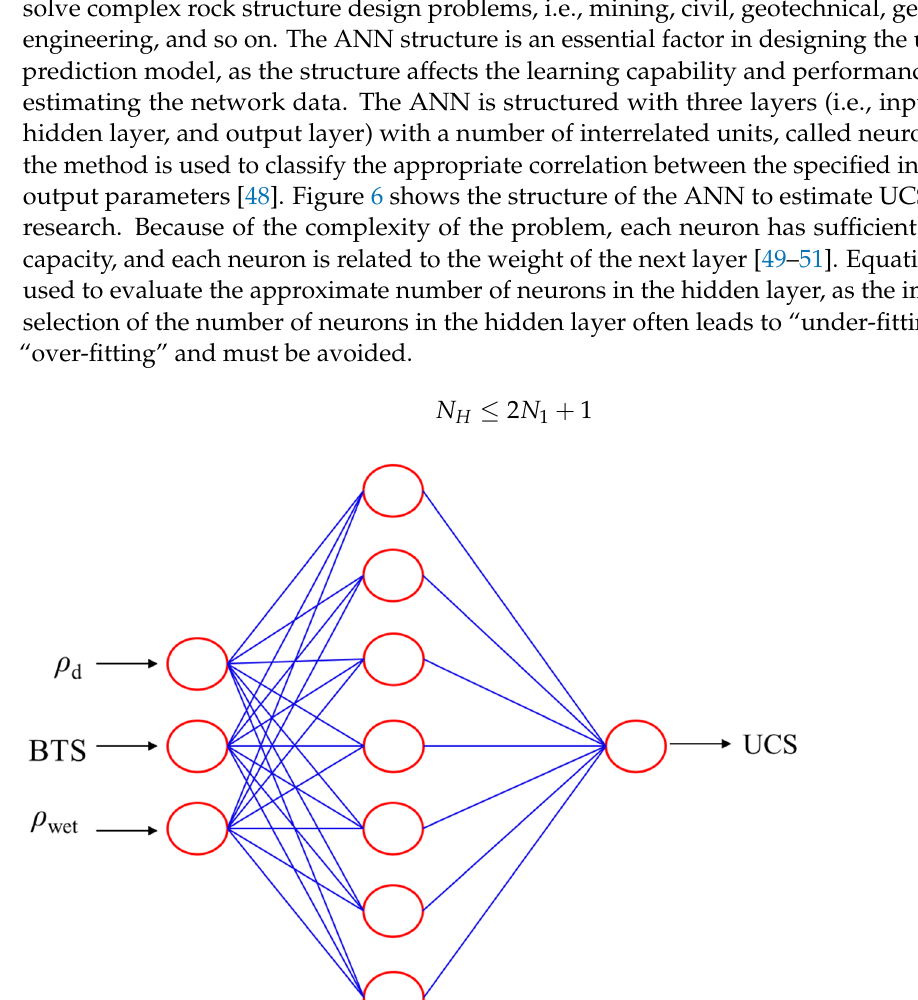
Figure 7. Validation performance curves of UCS at ( a ) M1, ( b ) M2, and ( c ) M3.